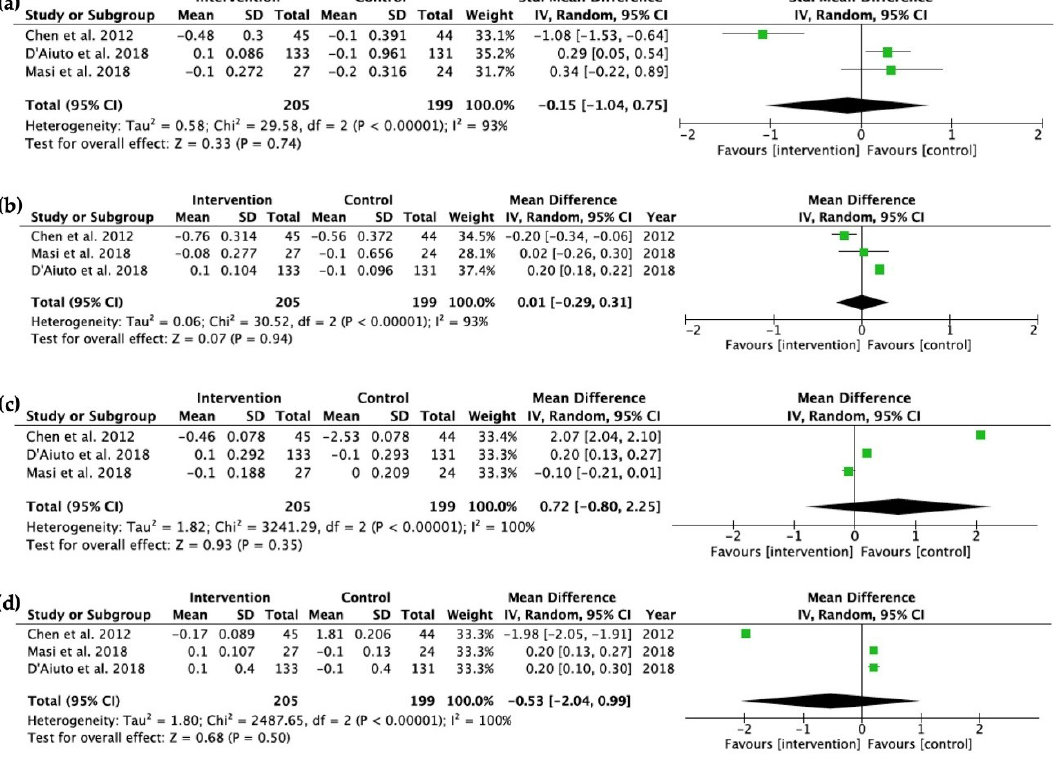
Figure4. Forestplotsdepictingthechangesof( a )totalcholesterol, ( b )triglycerides, ( c )LDL,and( d )HDL Figure 4. Forest plots depicting the changes of ( a ) total cholesterol, ( b ) triglycerides, ( c ) LDL, and ( d ) (all in mmol / L) between the intervention and control groups at baseline and the 6-month HDL (all in mmol/L) between the intervention and control groups at baseline and the 6-month follow- up.